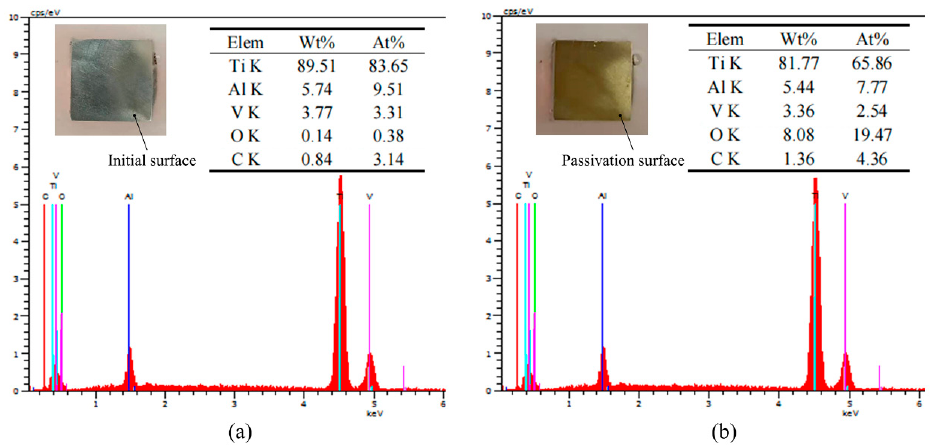
Figure 6. Energy-dispersive X-ray spectrometry (EDX) data for ( a ) initial surface and ( b ) passivated surface at 6 V for 2 min.